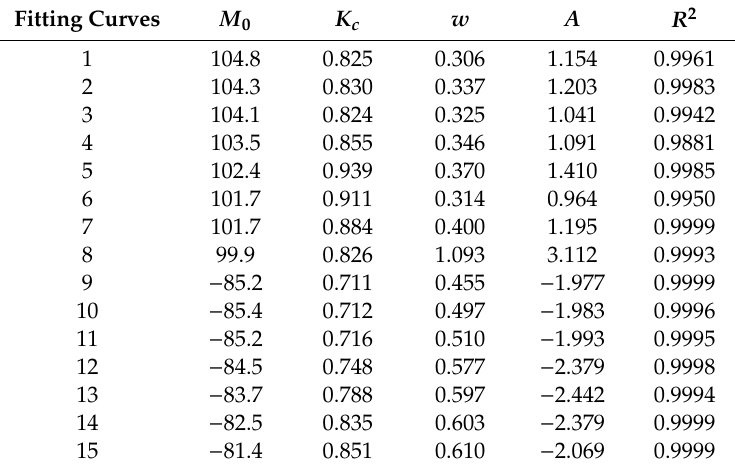
Table 4. Parameters of each lognormal fitting